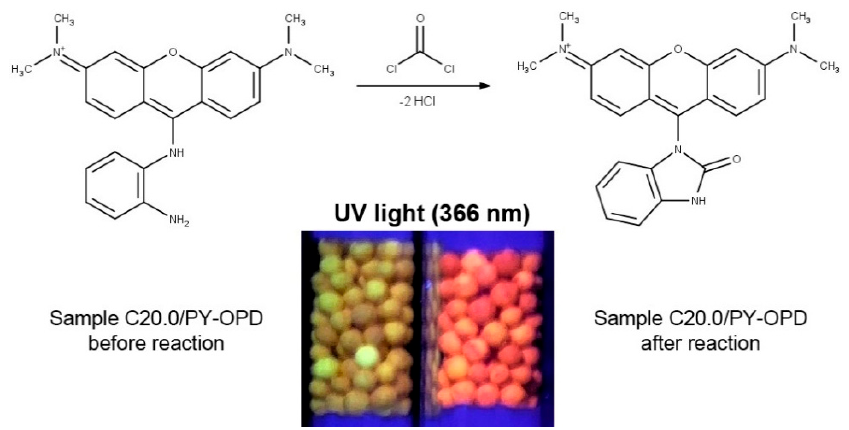
Figure 4. Reaction of o ‐ phenylenediamine ‐ pyronine (PY ‐ OPD) with phosgene and comparison of the impregnated sample C20.0/PY ‐ OPD under UV light at 366 nm before and after the reaction.